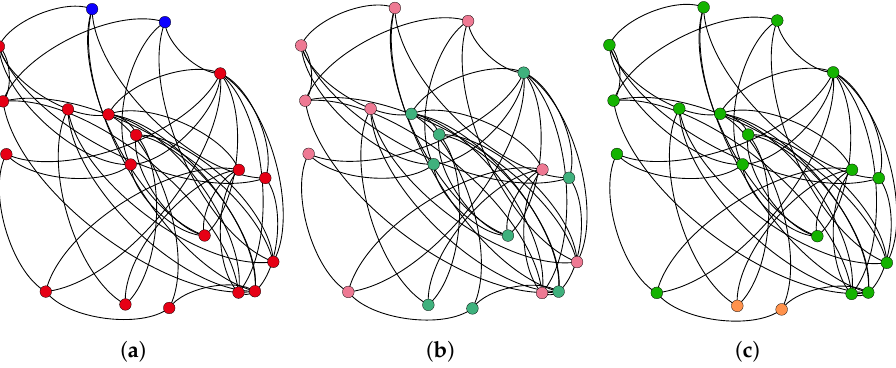
Figure 4. Initial conditions of the simulations; ( a ) Targets; ( b ) Efficient countermeasures; ( c ) Initial